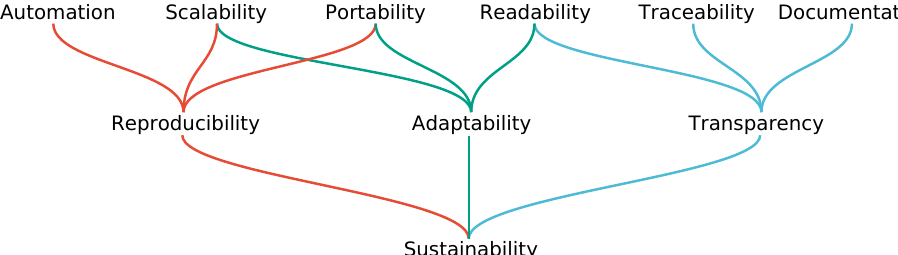
Figure 1. Hierarchy of aspects to consider for sustainable data analysis. By supporting the top layer, a workflow management system can promote the center layer, and thereby help to obtain true sustainability.